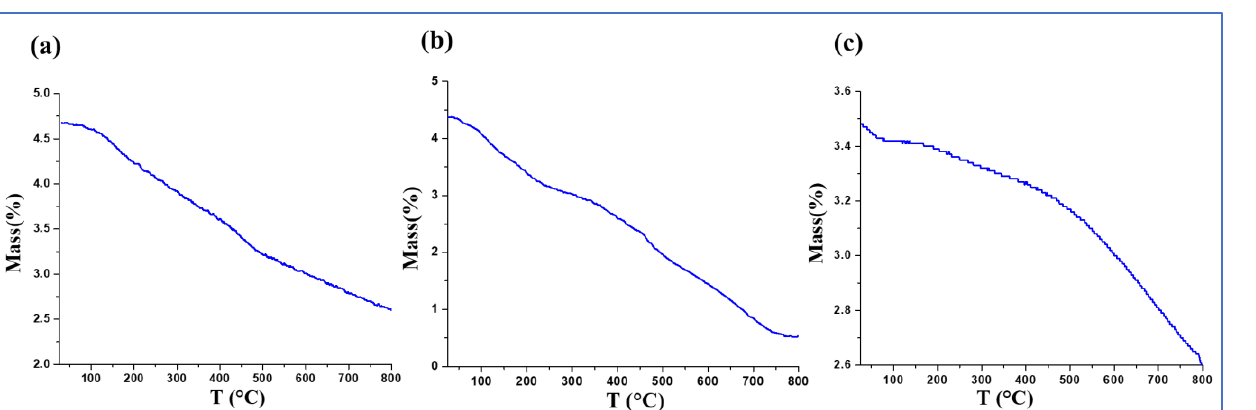
Figure 1. IR spectra of GO, GO-NCD- 1, and GO-NCD- 2. Thermal gravity analysis of the GO, GO-NCD- 1, and GO-NCD- 2 composites was carried out to understand their decomposition behavior. The important mass loss events that occur in TGA are <100 ◦ C for the elimination of water, 100–350 ◦ C for the loss of oxygen containing functional groups, and 350–1000 ◦ C for the oxidation pyrolysis of carbon framework [27]. GO-NCD- 1 and GO-NCD- 2 showed loss of mass at 150, 250, 350, and 500 ◦ C therefore confirming the successful loading of both the complexes on graphene oxide. The plot in Figure 2 shows, in fact, that GO is thermally stable up to 450 ◦ C, whereas both nanocomposites containing the Ru species are found to be thermally less stable, likely due to the loss of CO 2 and N 2 (Figure 2, Figures S7 and S8).